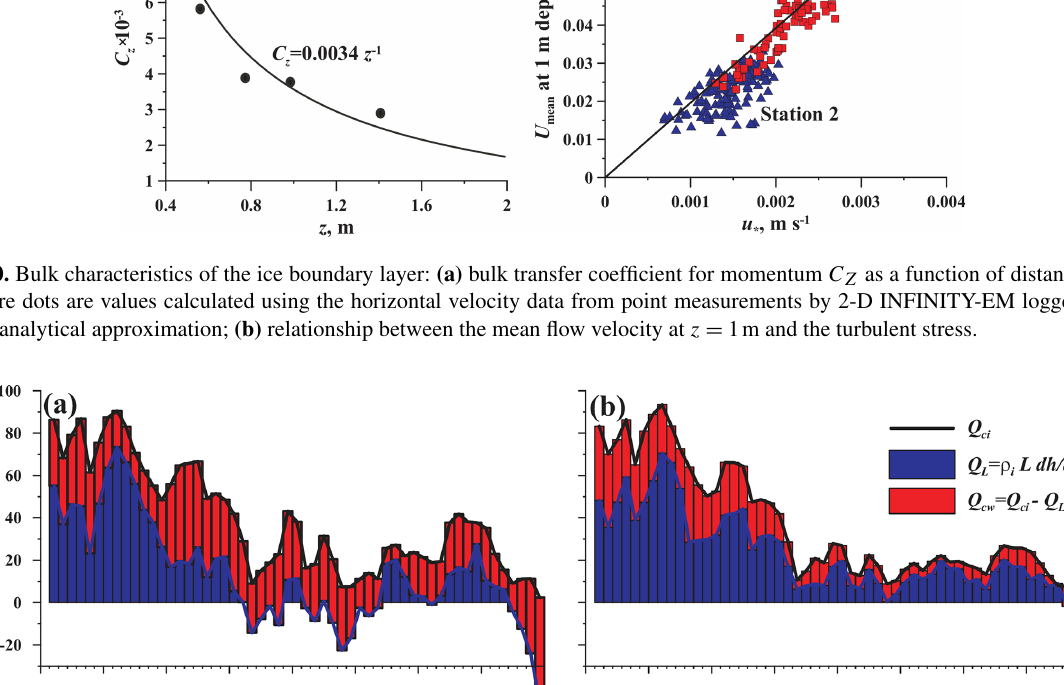
Here, ε is taken at the distance z crit = 0 . 85m from the ice base, which corresponds to the boundary between the ice- adjacent sublayer and the linearly stratified boundary layer (see Sect.